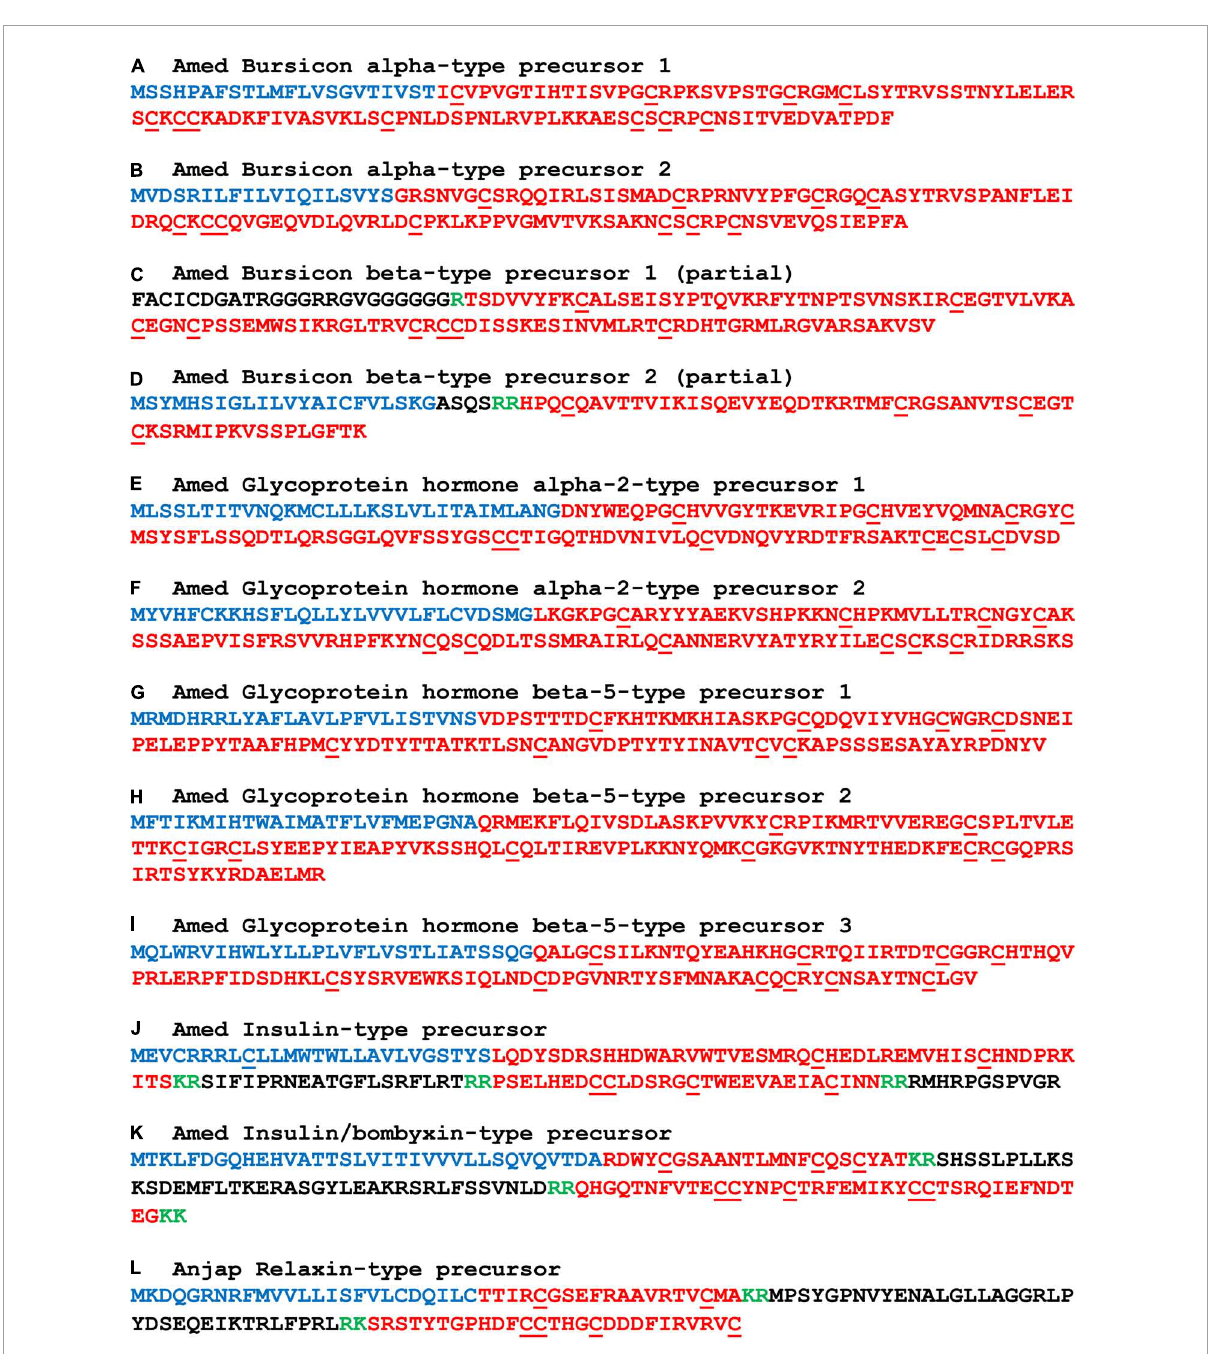
FIGURE3 Sequences of crinoid proteins that are precursors of heterodimeric neuropeptides. Neuropeptide precursor sequences are shown in alphabetical order and are from Antedon mediterranea (Amed), with the exception of relaxin-type precursor which was not identified in this species but which was identified in Anneissia japonica (Anjap). The predicted signal peptide is shown in blue, predicted monobasic/dibasic cleavage sites are shown in green and predicted neuropeptides are shown in red. The underlined cysteine residues have been shown to form intramolecular or intermolecular disulphide bridges in homologous heterodimeric neuropeptides in other taxa. The DNA sequences of transcripts encoding these precursors are shown in Supplementary File 2